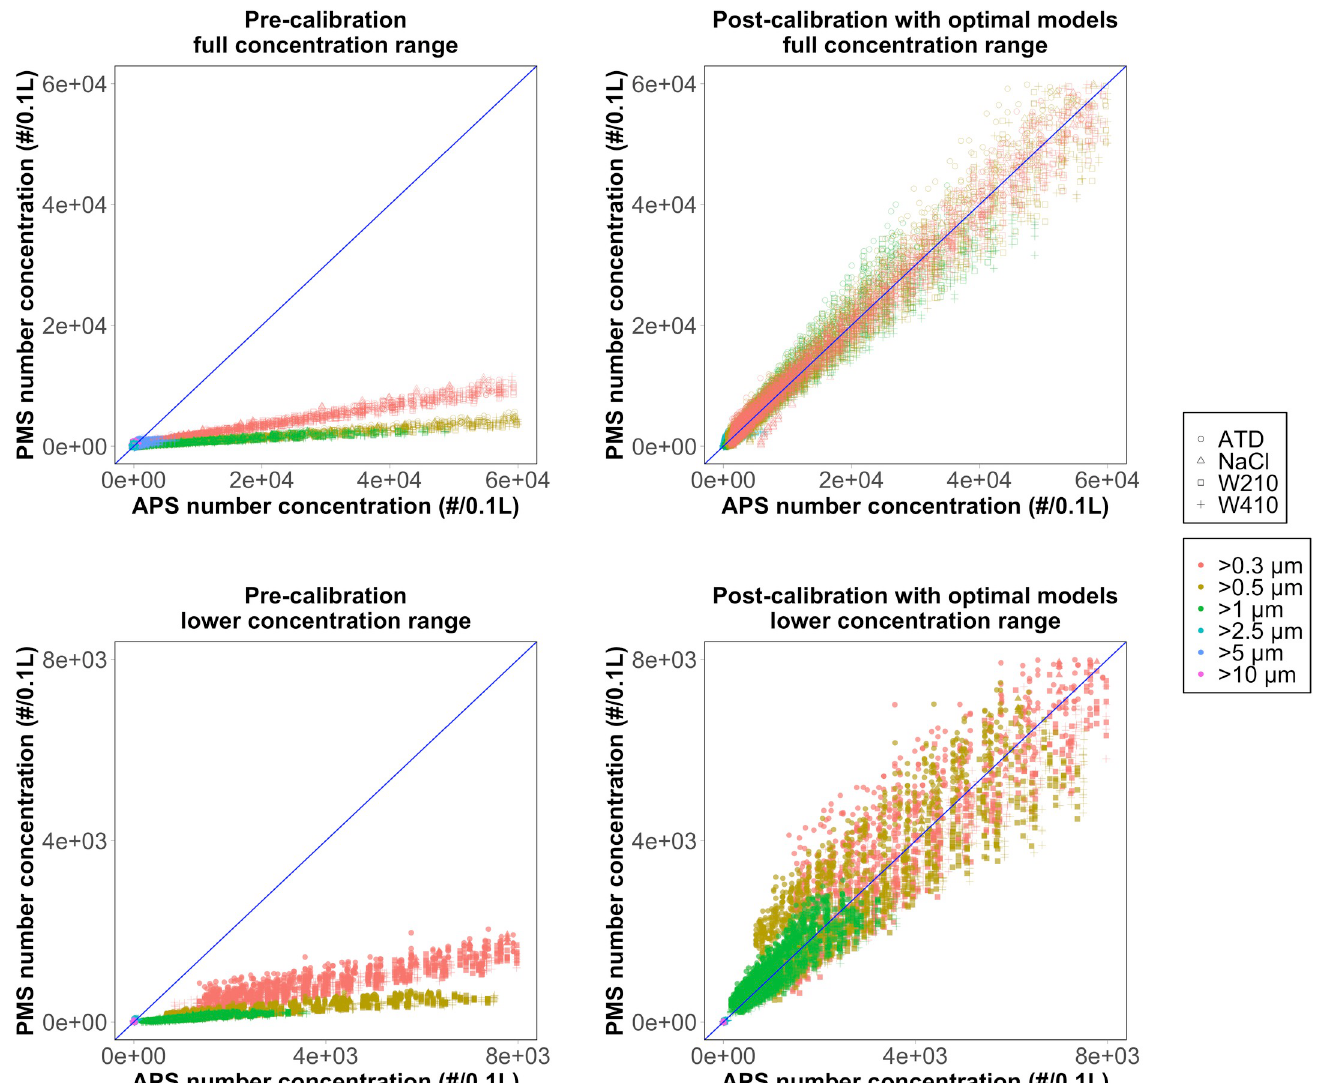
Fig 5. A comparison of the pre-calibrated and post-calibrated number concentrations by full and lower concentration range. The blue line represents the 1:1 relationship between the PMS and APS